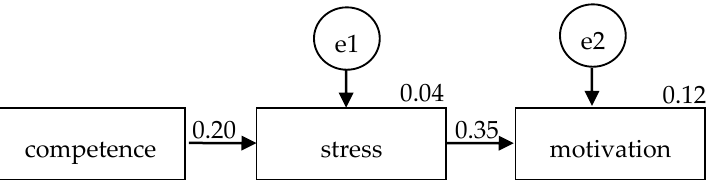
Figure 2. Relationships between disaster nursing competence, disaster stress, and motivation for disaster engagement.